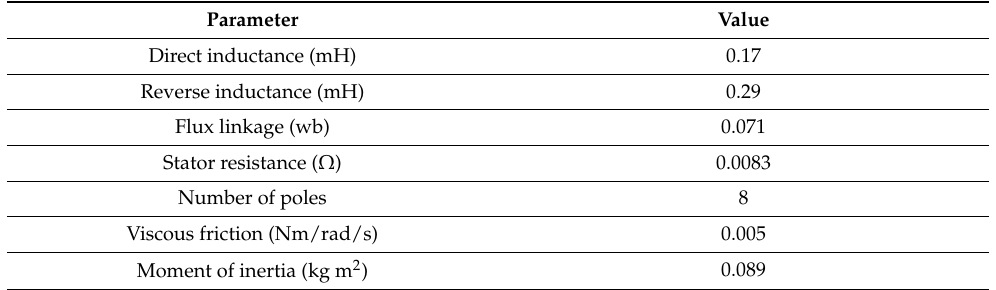
Table 4. 100 kw PMSM parameters.